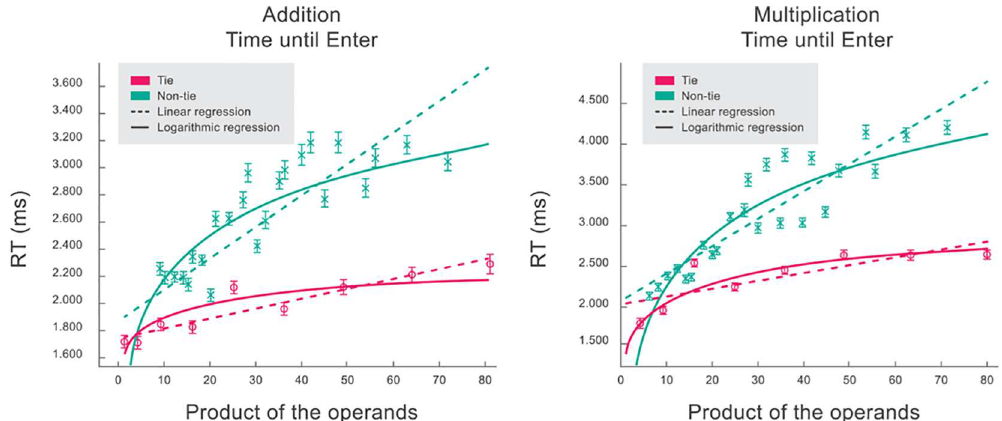
Fig 4. RTs for addition and multiplication in one-by-one-digit problems as a function of the product of the operands. Inter-subjects means and standarderrors RTs are shown as a function of the product of the operands for tie and non-tie problems. Linearand logarithmic regressionresults are included.